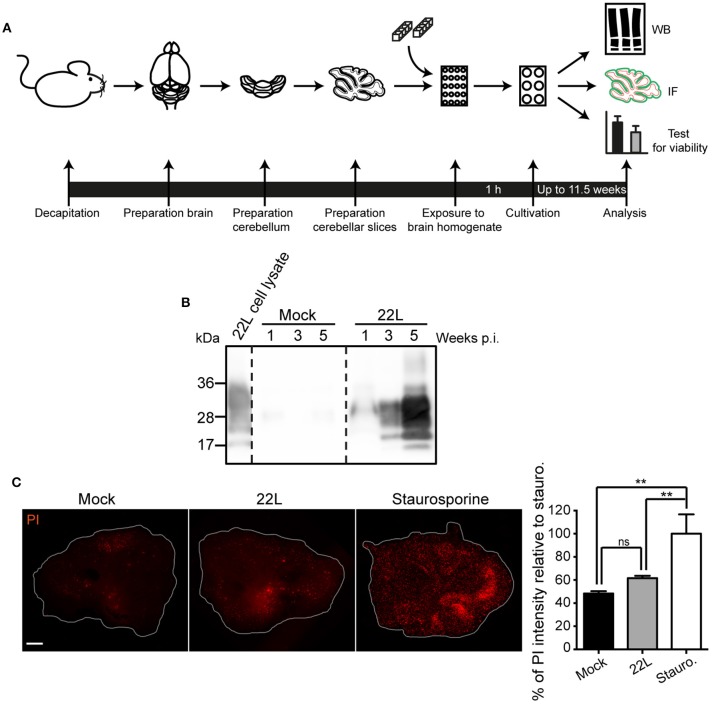
Viability of sagittal cerebellar slices infected with 22L prions. (A) Experimental setup. Organotypic slices of cerebella from 9 to 13 days old C57BL/6JRj mice were prepared and exposed to 20 mg/ml 22L brain homogenate or Mock brain homogenate. Slices were cultured on membrane inserts for up to 11.5 weeks. (B) Cerebellar slices exposed to Mock brain homogenate or infected with 22L prions were cultured for up to 5 weeks and slice lysates were subjected to proteinase K (PK) treatment. PrPSc was detected by western blot using mAb 4H11. (C) Slices were cultured for 10.5 weeks and subsequently stained for dead cells using propidium iodide (PI). Slices treated with 5 μM staurosporine served as positive controls. Samples were analyzed by epifluorescence microscopy using the tile scanning function with identical imaging settings. Scale bar: 500 μm. Statistical analysis was performed using One-way ANOVA with Tukey's multiple comparisons test. Asterisks indicate significant changes (n = 3; **p < 0.01; ns, not significant). WB, western blot; IF, immunofluorescence; p.i., post infection; Stauro., staurosporine.